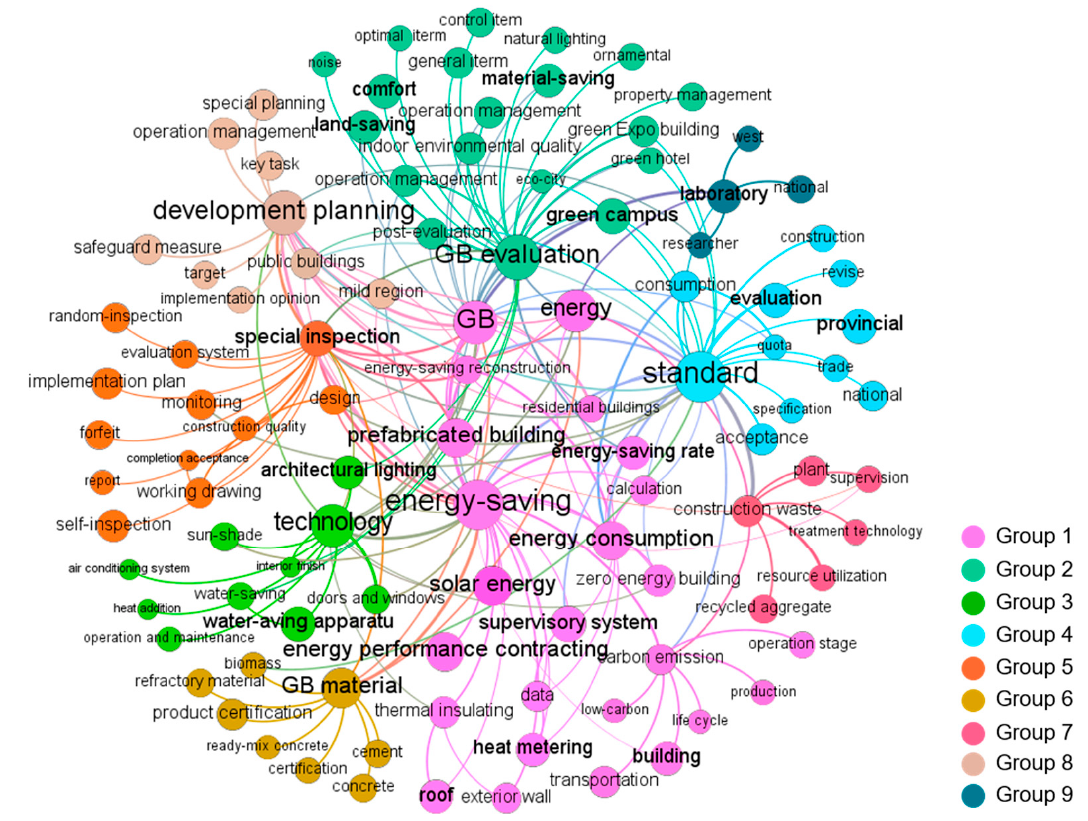
Figure 6. Co-word network of China’s GBPs in stage 5.